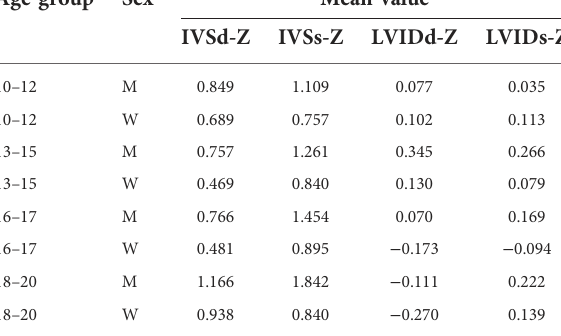
TABLE 3 Z-scores of echocardiographic